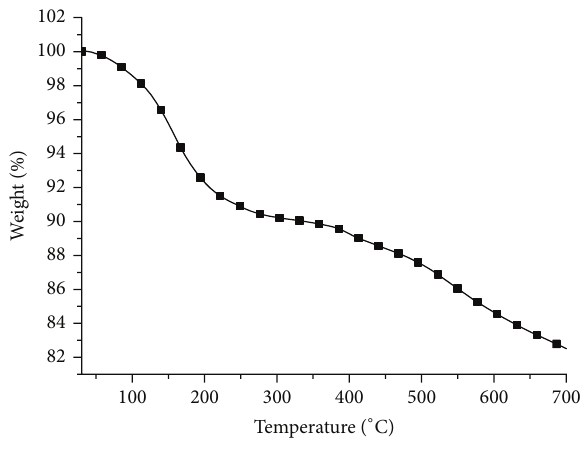
Figure 5: The TGA curve of NiP.